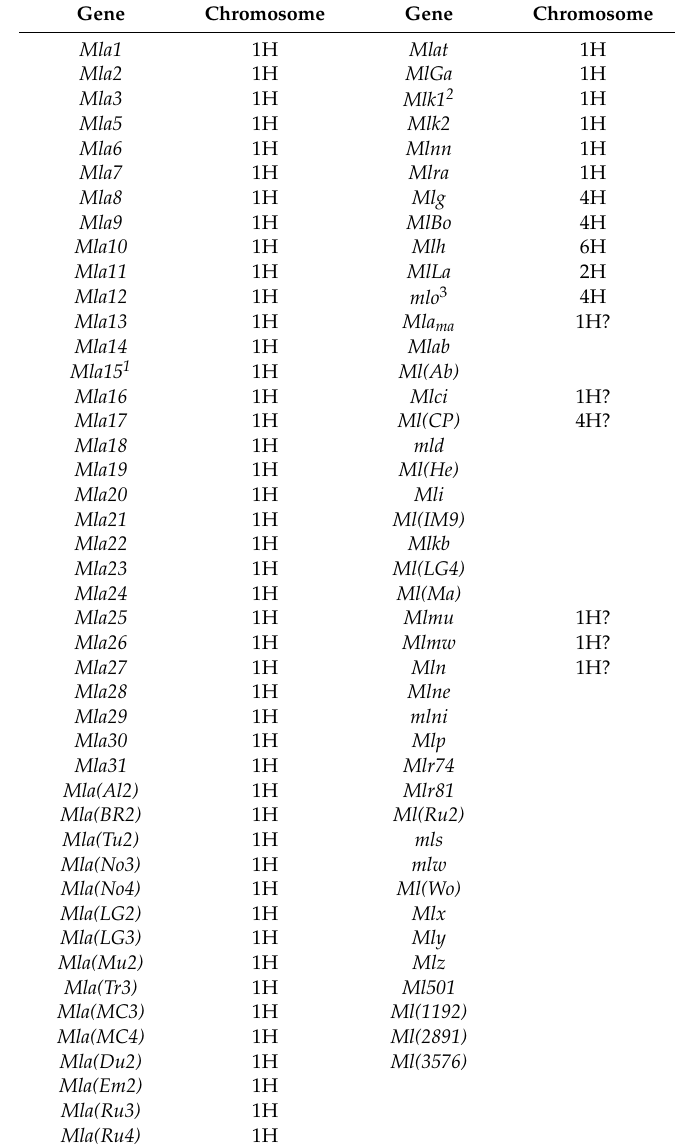
Table 1. Previously described barley powdery mildew resistance genes [21]. Gene Chromosome